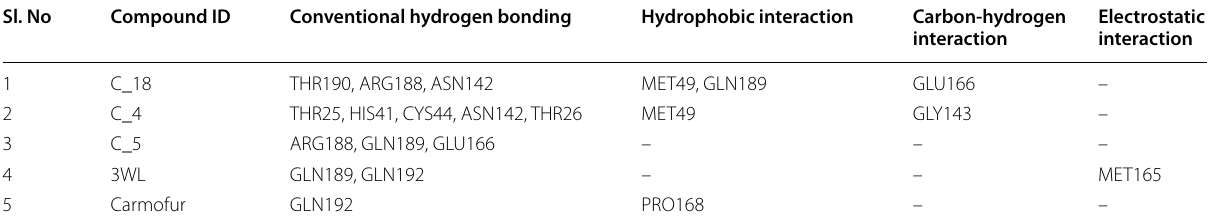
Table 5 Binding parameters of the phytocompounds and the standard references with the amino acid residues at the active binding site of SARS-CoV-2 M pro Sl.